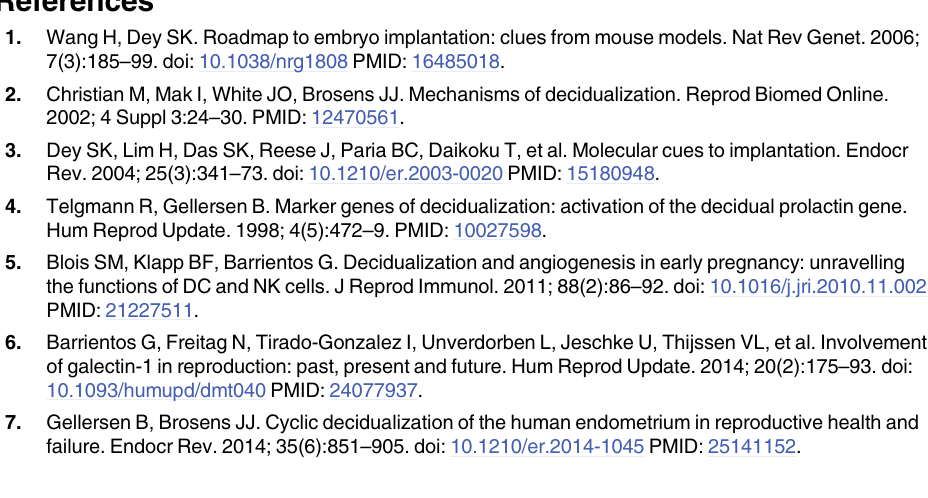
S1 Table. A complete list of decidualization-related